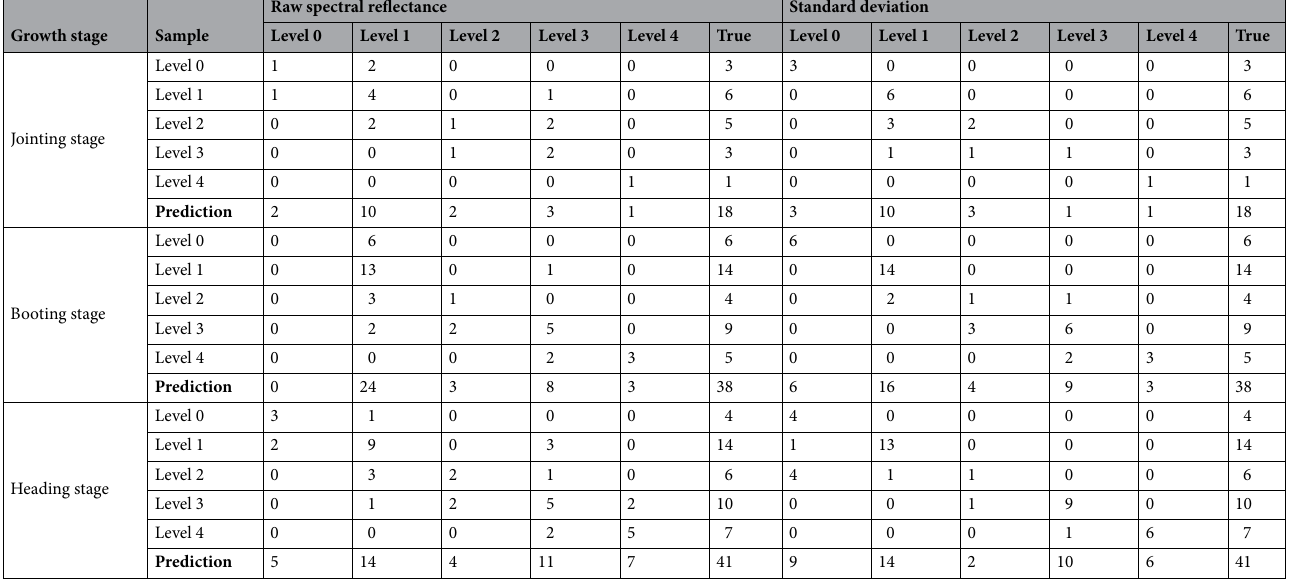
Table 4. Performances of the PNN models at different growth